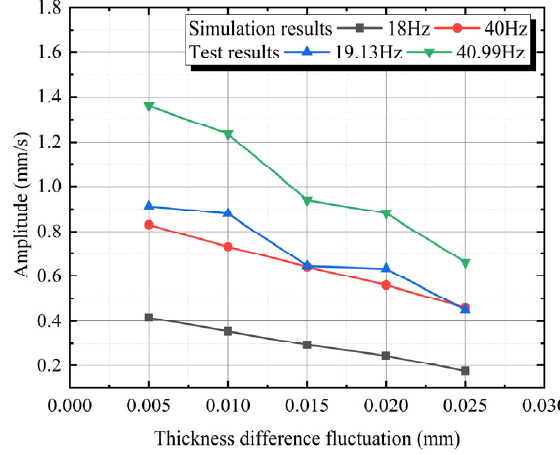
Figure 12. Vibration mechanics model with strip thickness fluctuation.